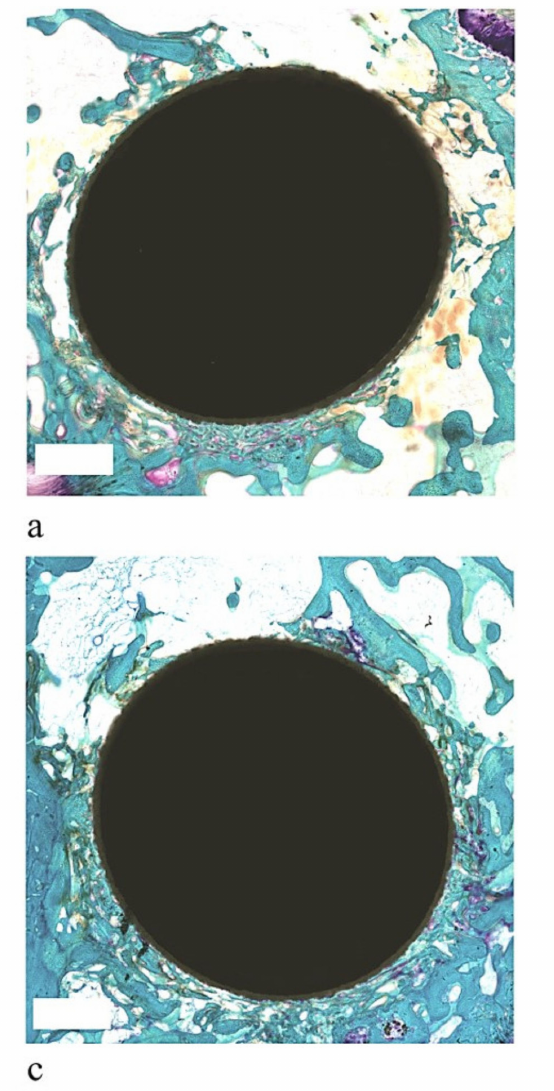
Figure 3. Histological images showing bone osteointegration 4 weeks after surgery. ( a ) Ti-HA; ( b ) Ti-HA + BMSC; ( c ) Ti-HA + PRP; ( d ) Ti-HA + BMSC + PRP. Toluidine Blu, Acid Fuchsin, and Fast Green staining; magnification 2.5 ×